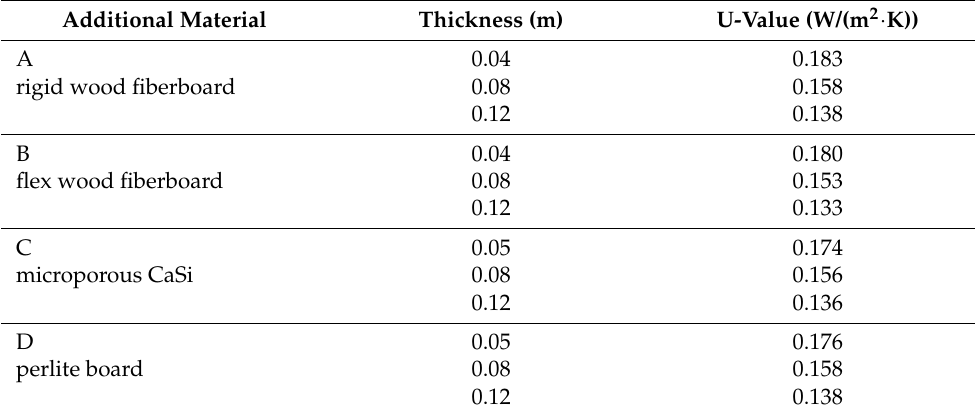
Table 3. Final thermal transmittance of the external wall.